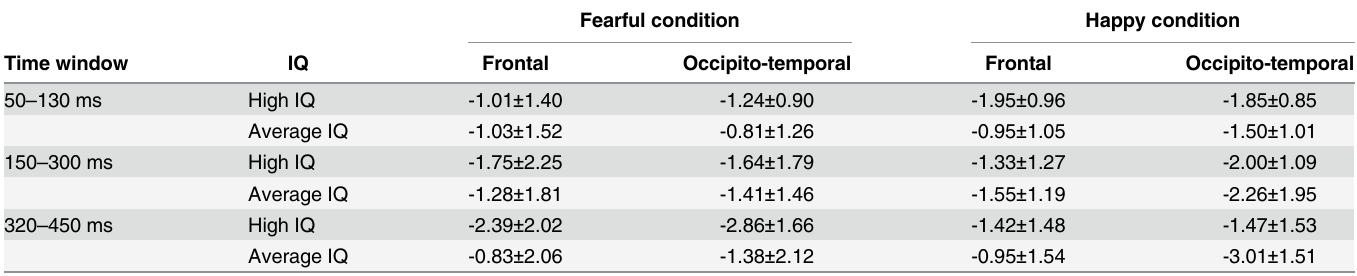
Table 2. Means and standard deviations of vMMN amplitudes ( μ V) in each expression condition. Fearful condition Happy